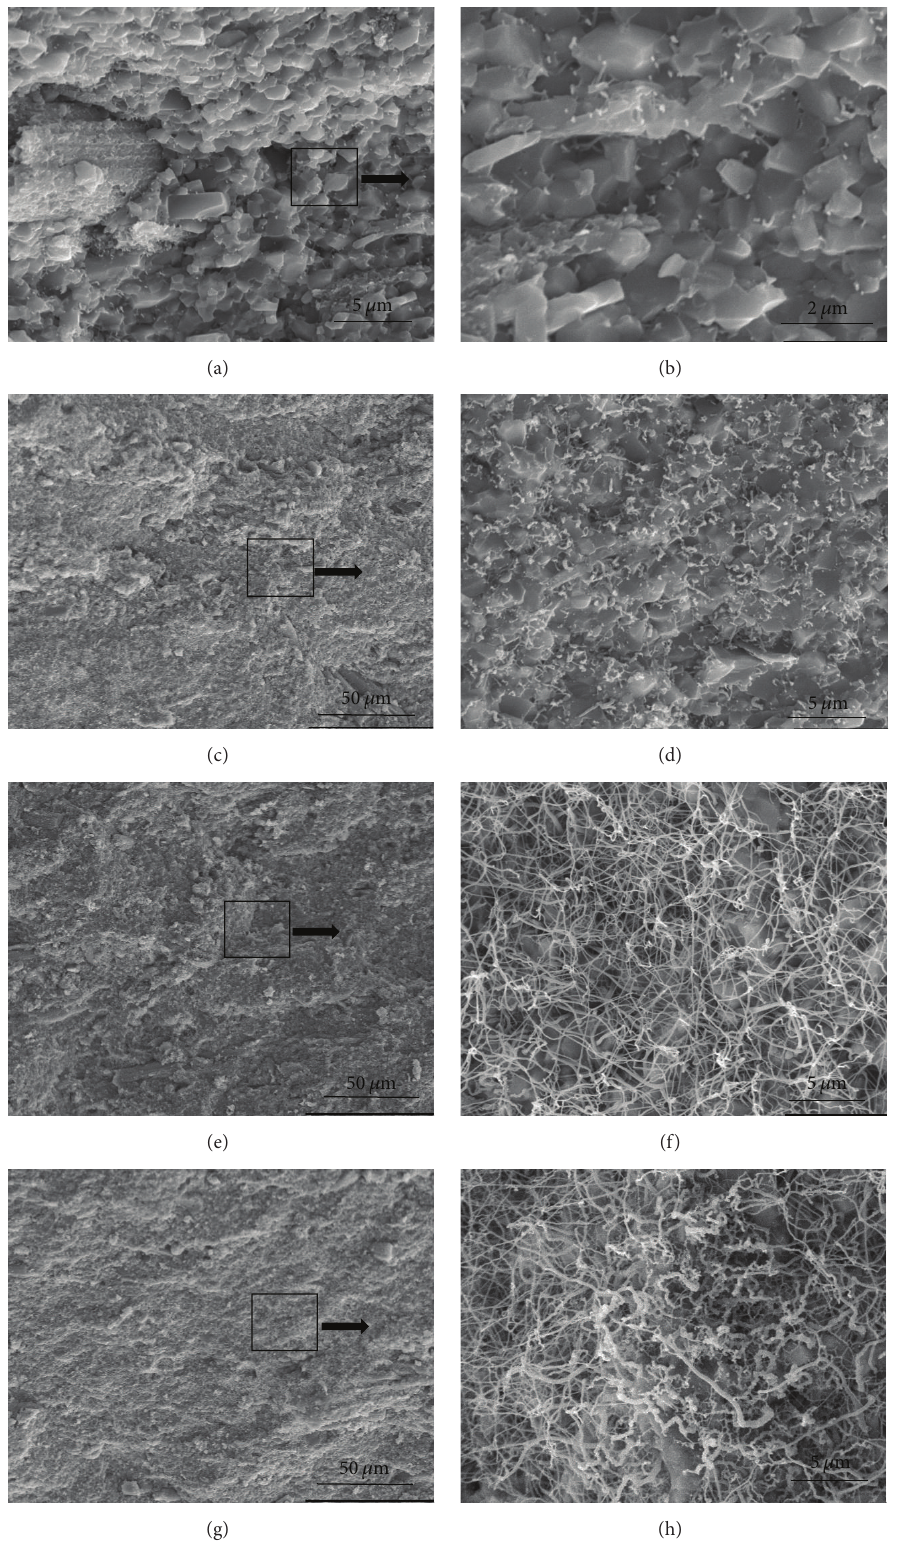
Figure 3: Fracture morphology of annealed specimens, (a) and (b), (c) and (d), (e) and (f), and (g) and (h) for AM10, AM30, AM60, and